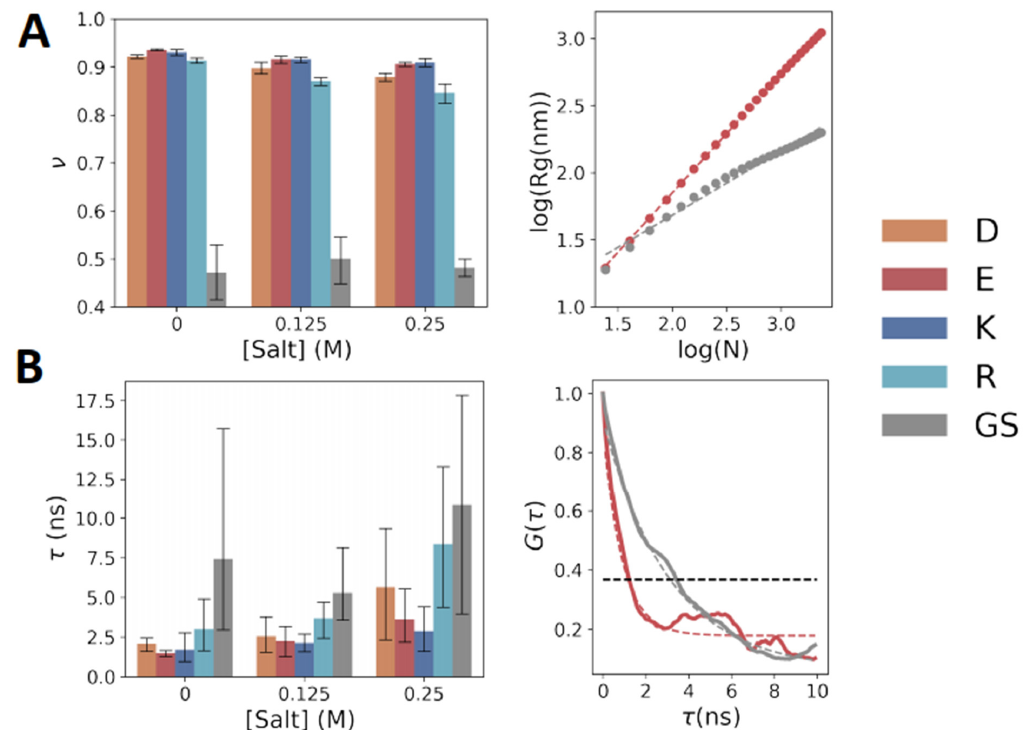
Figure 4. Polymeric properties of charged homo-polypeptides. ( A ) (Left) Flory exponent, υ , of the five simulated polypeptides at three salt concentrations, extracted from the relation Rg ~ |i-j| υ (see main text for details). Error bars are the standard deviation of υ obtained from five independent simulations for each polypeptide. (Right) Representative example of the extraction of υ from the slope when plotting Rg versus |i-j| on a log–log plot. Data are shown for polyE (red circles) and polyGS (gray circles), and the dashed line is the best linear fit. ( B ) Relaxation times for Rg at three different salt concentrations. Values of τ were extracted by fitting the auto-correlation function, G(t), of Rg to a single exponential function (example on right panel for polyE and polyGS).